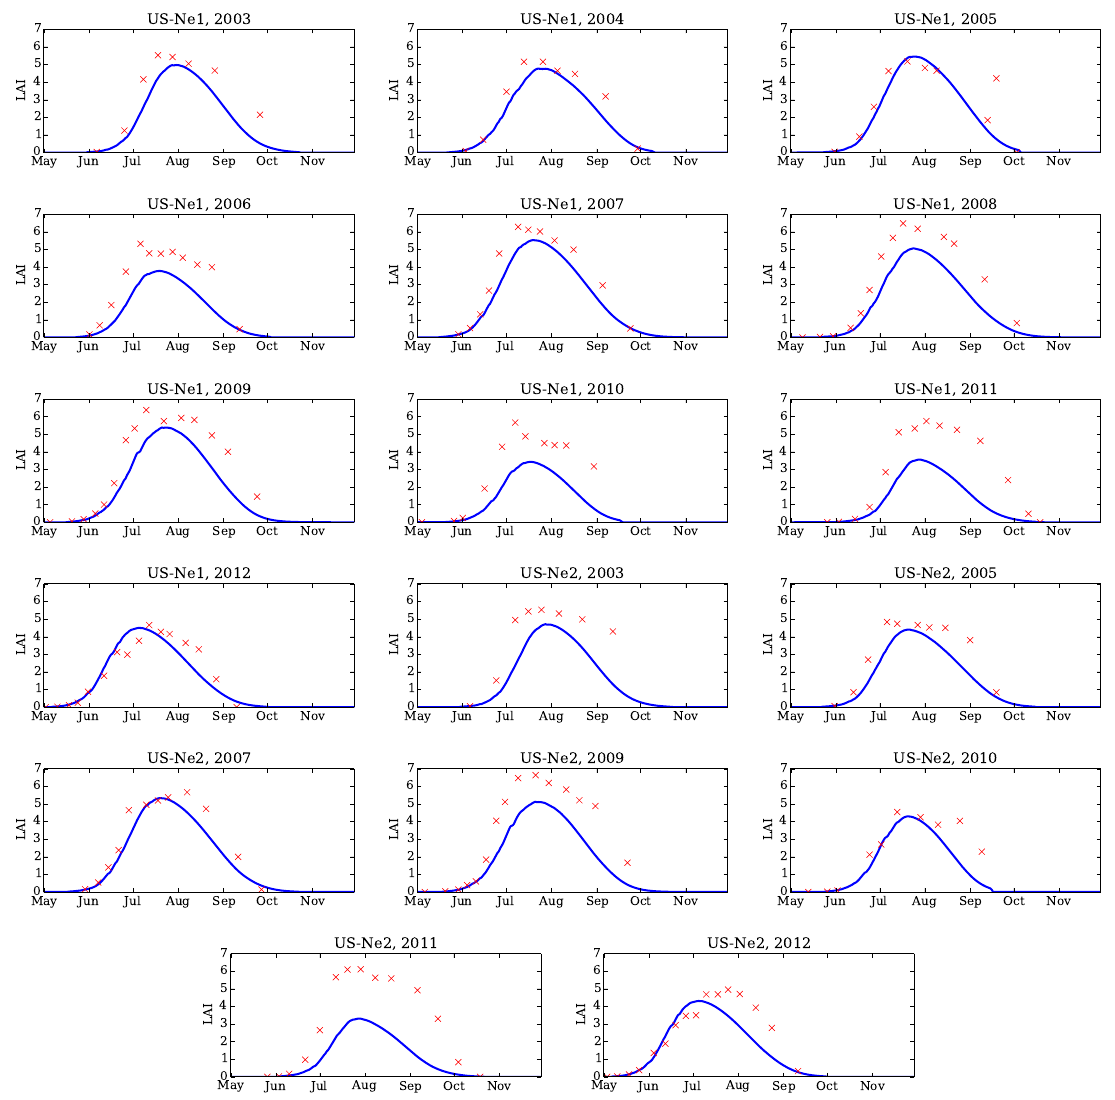
Figure 23. Time series of LAI for irrigated maize at the Mead FLUXNET sites US-Ne1 and US-Ne2; blue: model; red: observations. JULES runs have the crop model switched on and the input parameters in Tables 1, 2, 3, and 4.